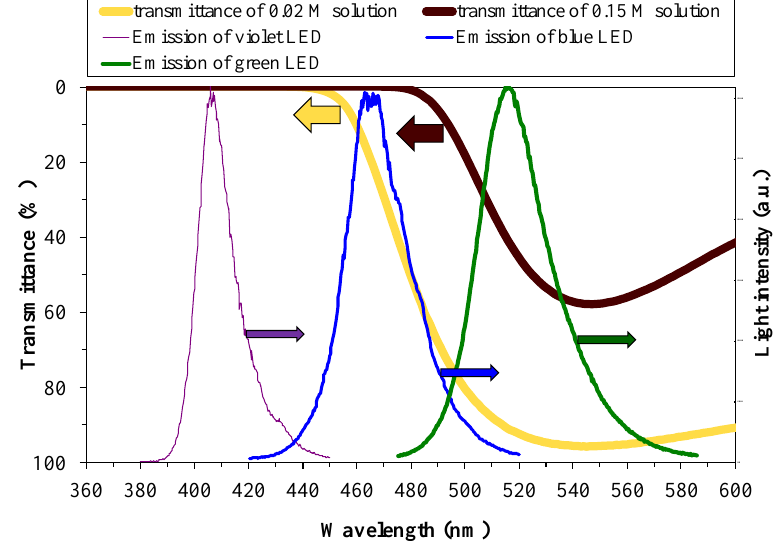
Figure 2. Emission spectra of violet, blue, and green LED strips and the transmittance spectra of 0.02 M and 0.15 M potassium iron(III) oxalate solutions. Table 2. Incident photon fluxes determined by potassium ferrioxalate actinometry. Irradiation (Using 0.15 M Fe-Oxalate Solution)